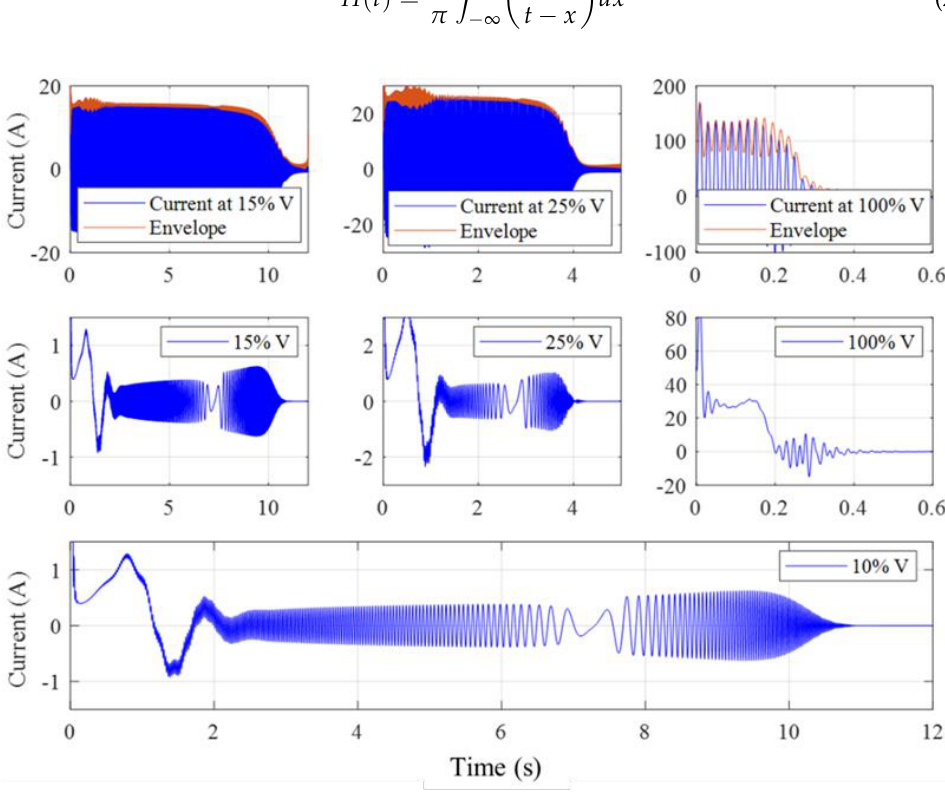
Figure 4. The motor’s simulated startup currents at different voltage levels ( top row ), the recov- ered nonstationary signal ( middle row ) and the nonstationary signal at 10% of the rated voltage representing the changing frequency pattern ( bottom ).